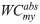
Tested neuroimaging modalities.A) Serotonin system—[11C]CUMI and [11C]WAY100635 PET imaging are used as 5HT1A receptor markers (agonist and antagonist respectively). The protein density maps are images of non-displaceable specific binding, BPND [unitless] and volume of distribution, VT [ml/cm3], respectively. B) Myelin system–MR-based absolute myelin water content modality (WCmyabs, [unitless]) is used as myelin density marker. C) Dopamine system–[11C]Raclopride PET imaging is used as D2/D3 receptor maker; [123I]FP-CIT SPET imaging is used as dopamine transporter (DAT) marker; [18F]FDOPA PET imaging refers to dopamine synthesis capacity (DDC, dopa decarboxylase enzymatic rate). The parametric maps are images of non-displaceable specific binding, BPND [unitless], index of uptake IU [unitless] and rate of net uptake, Ki [ml/cm3], respectively.